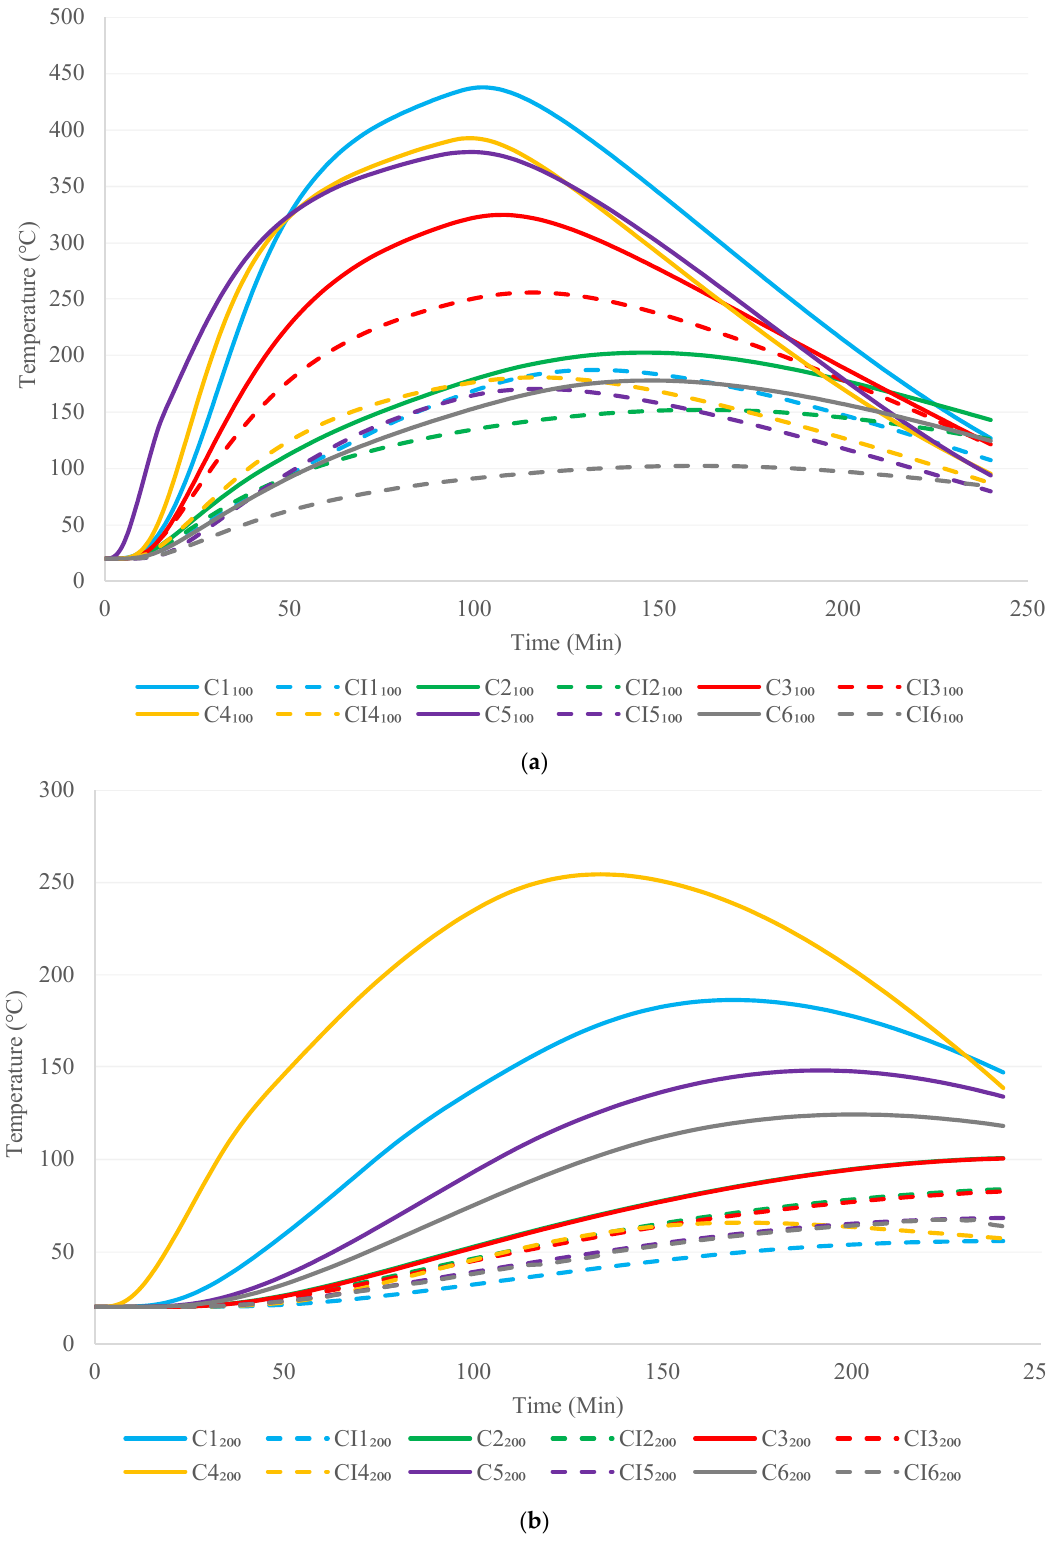
Figure 12. ( a ) Unexposed surface temperature variation of 100 mm wall configurations subjected to prolonged fire. ( b ) Unexposed surface temperature variation of 200 mm wall configurations subjected to prolonged fire.